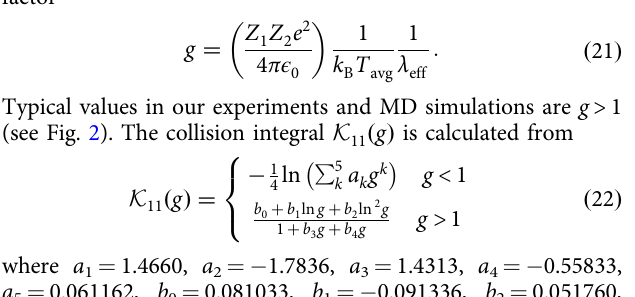
a 5 = 0.061162, b 0 = 0.081033, b 1 = − 0.091336, b 2 = 0.051760,